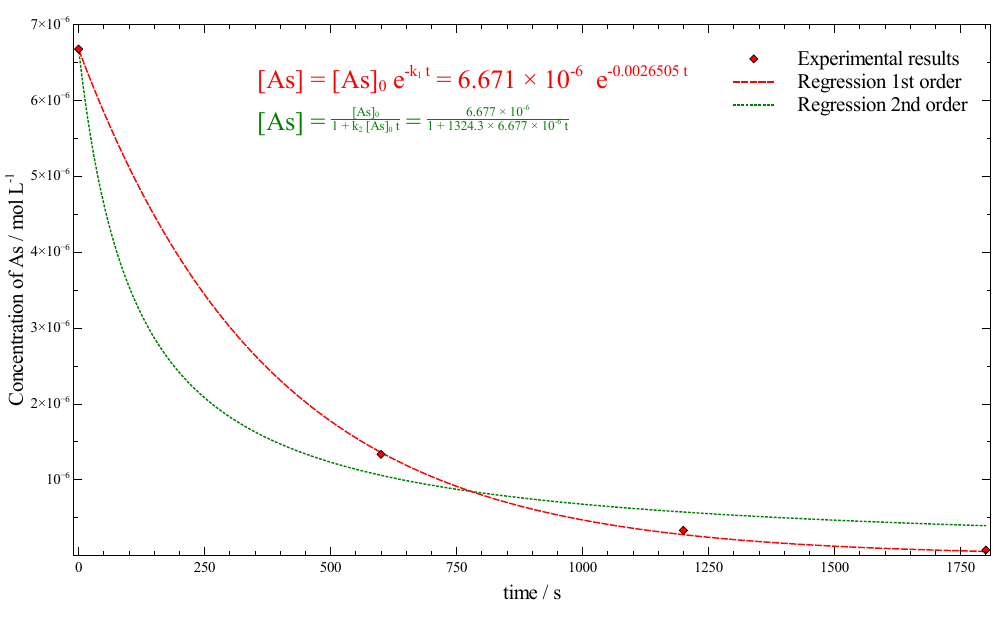
Figure 5. Kinetic data and first and second order